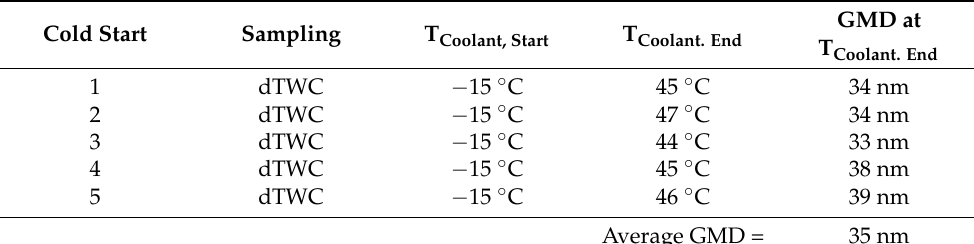
Table 5. Geometric mean diameter (GMD) for several cold start measurements.